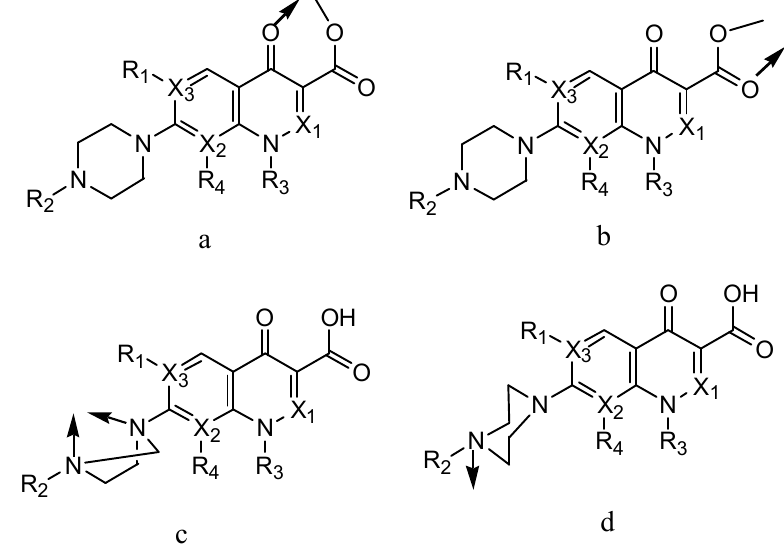
Figure 2. Four chelation modes of quinolones with metal ions.